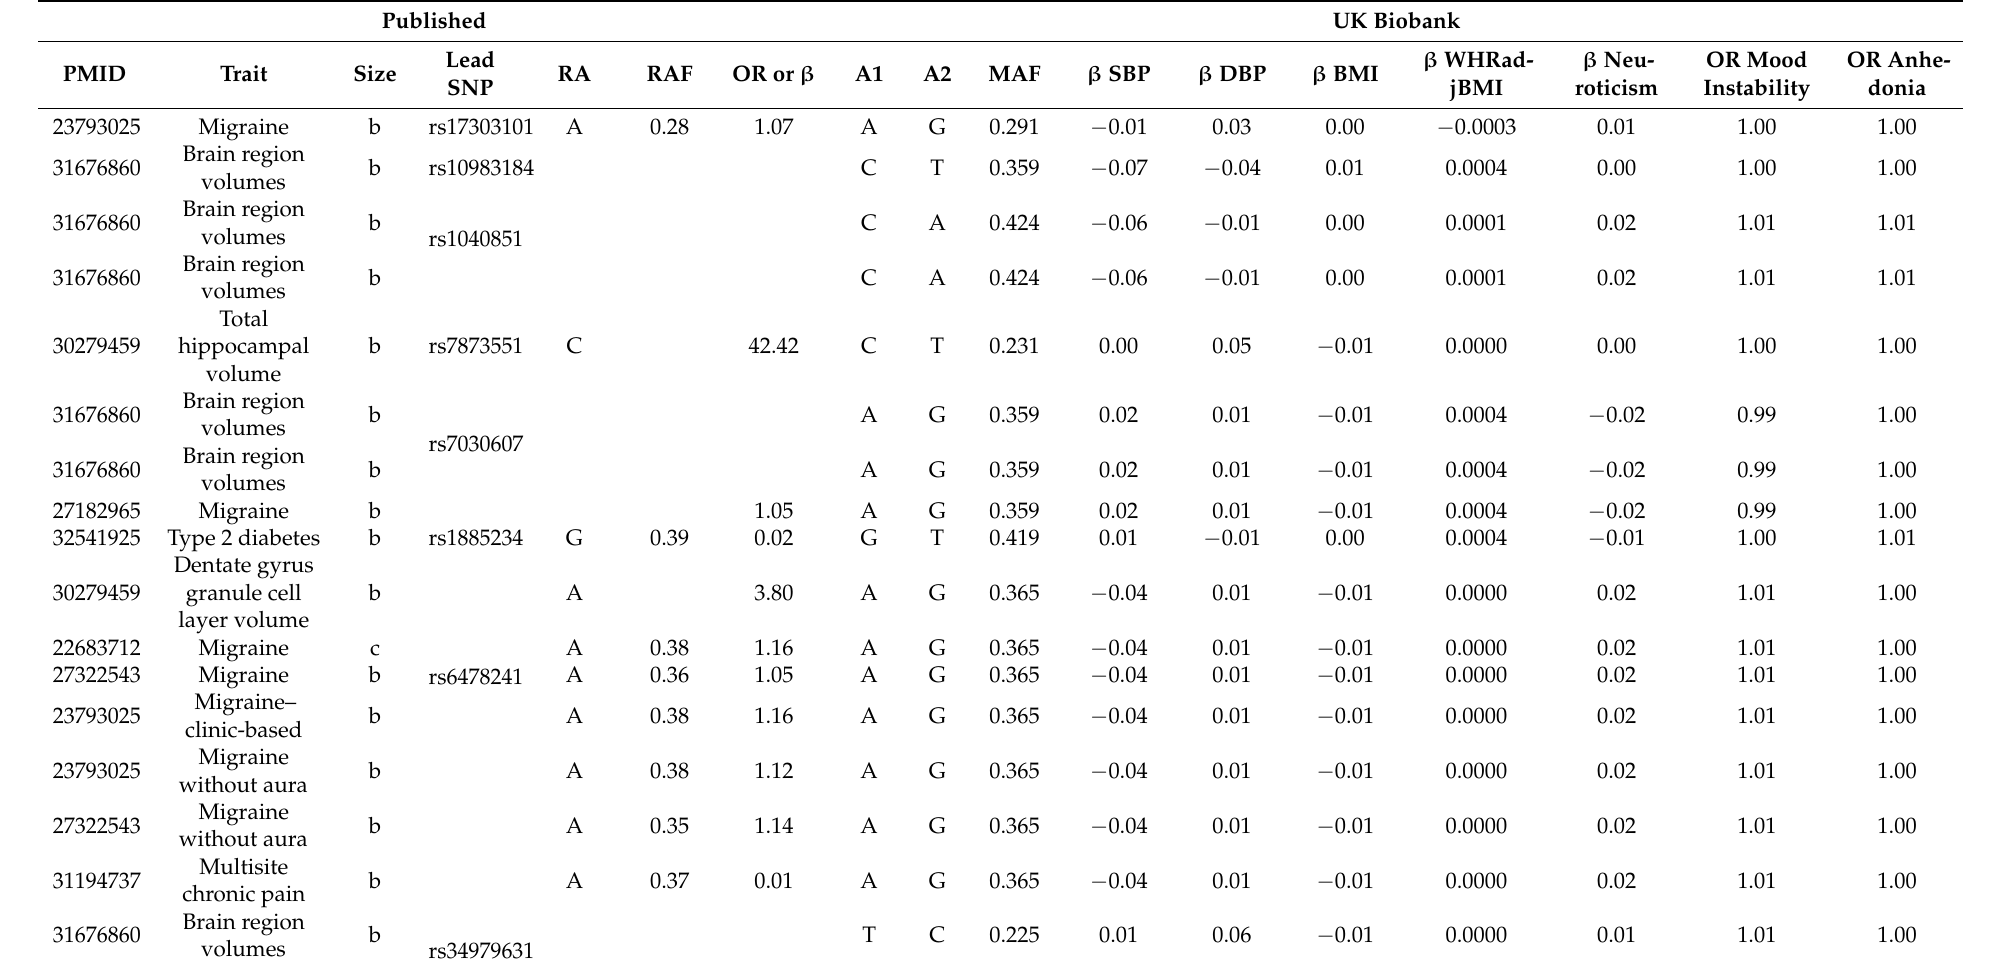
Table 3. Reported associations between the ASTN2 locus and psychological or cardiometabolic traits. Published UK